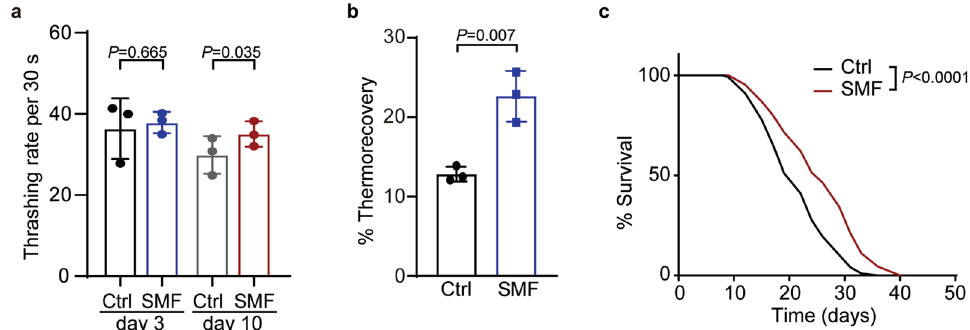
Figure 1. A moderate static magnetic field promotes worms longevity. ( a ) Worms treated with SMF of 10 mT were examined for their thrashing rates at indicated ages. Paired t -test. ( b ) SMF of 10 mT increases the recovery rate from heat shock in worms at day 1 of adulthood. Unpaired t -test. ( c ) SMF of 10 mT extends the lifespan of WT worms. Mantel-Cox Log Rank test. See Supplementary Table 1 for